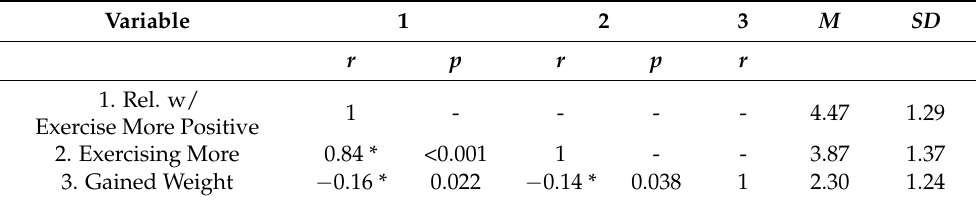
Table 3. Correlations between Observed Variables before COVID-19